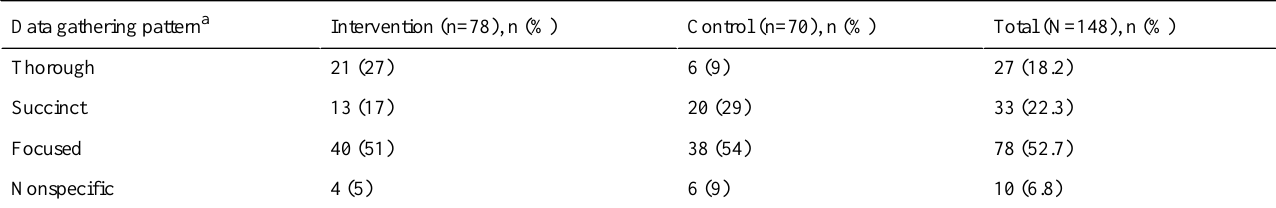
Table 2. Data gathering patterns observed in the electronic Clinical Reasoning Educational Simulation Tool in the trial